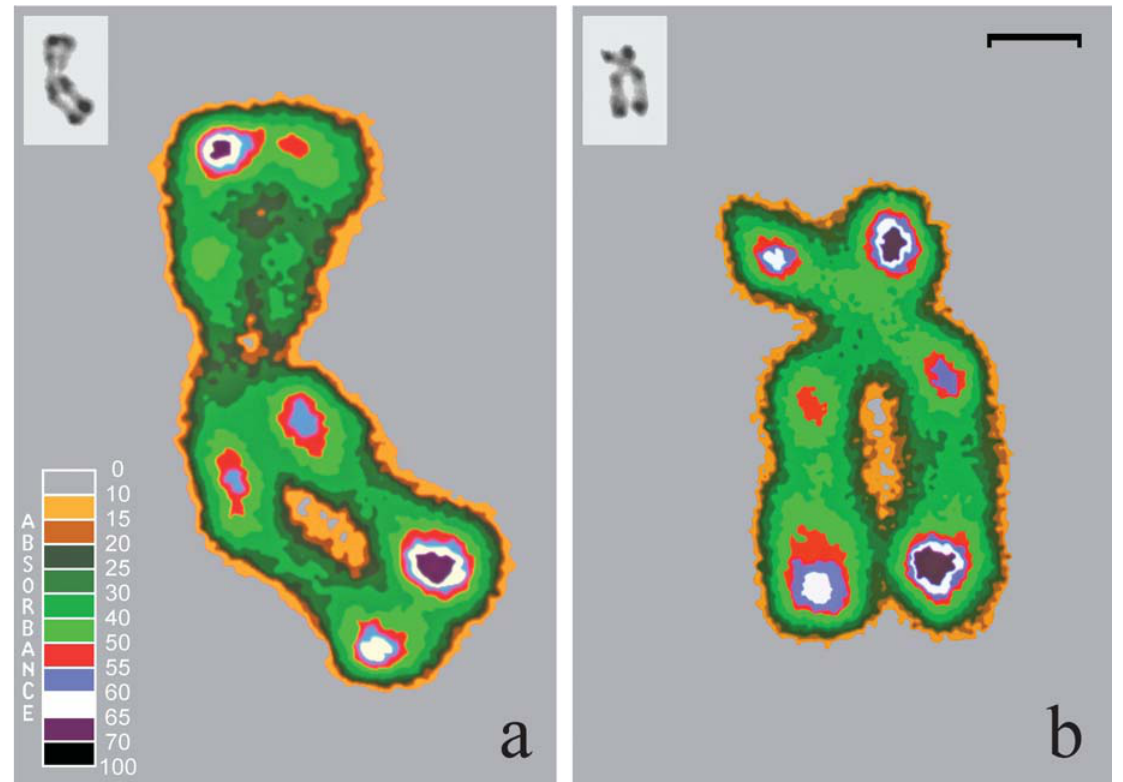
Figure 1 - Graphic images of T-banded human chromosomes showing TRANS ( a ) and CIS ( b ) configurations obtained through microdensitometric scan- ning and computer graphic image analysis. Remnants of R-bands are still observed since T-bands are a sub-set of them. Insets illustrate microscopic images of the scanned T-banded chromosomes. Bar = 1 μ